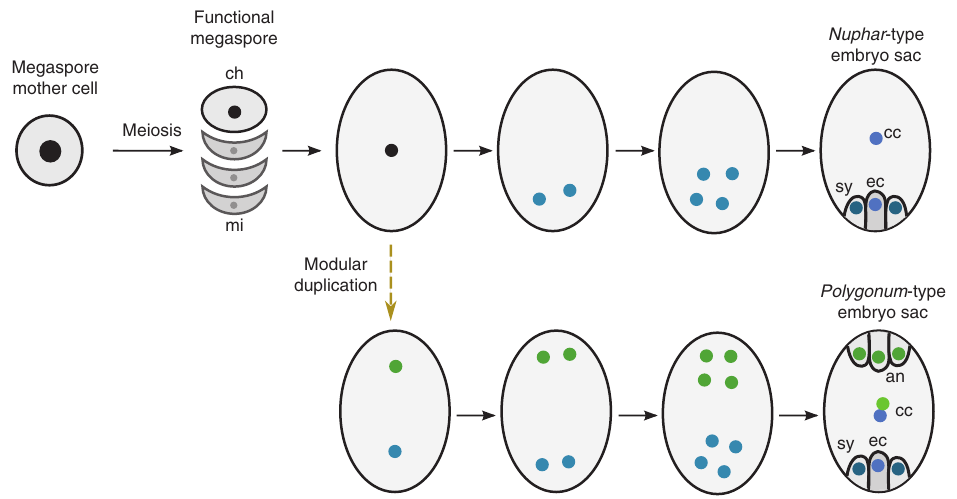
Figure 2 Development of Polygonum-type and Nuphar-type embryo sacs, showing how a duplication of a quartet module could give rise to the doubling in ploidy of the central